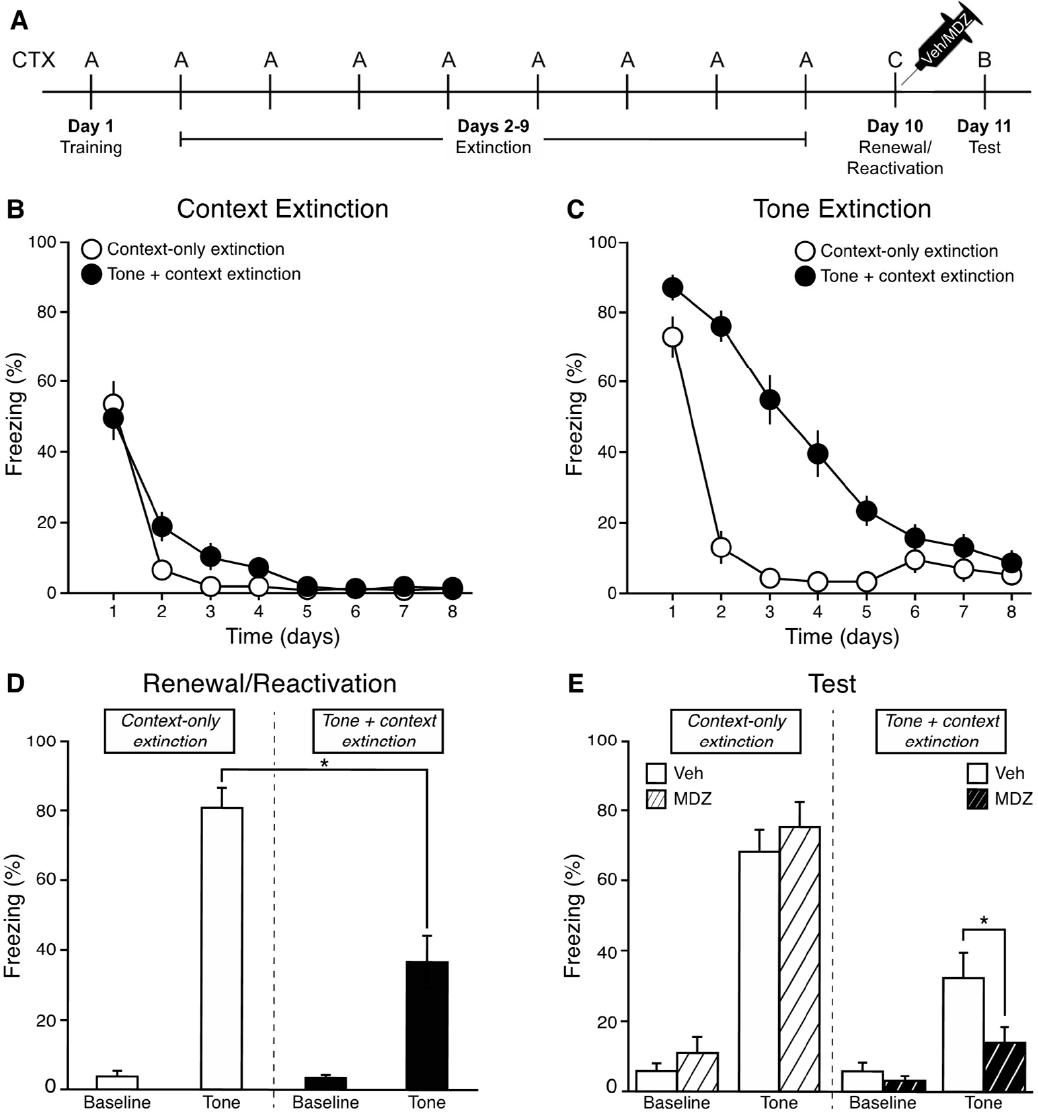
Figure 1. Timeline of Experiment 1 ( A ). Freezing during the first 3 min (context) of each extinction session ( B ). Freezing during the first tone presentation (or equivalent) of each extinction session ( C ). Freezing during the 3 min baseline and tone presentation of the renewal/reactivation session ( D ). Freezing during the 3 min baseline and 3 tone presentations (averaged) of the test ( E